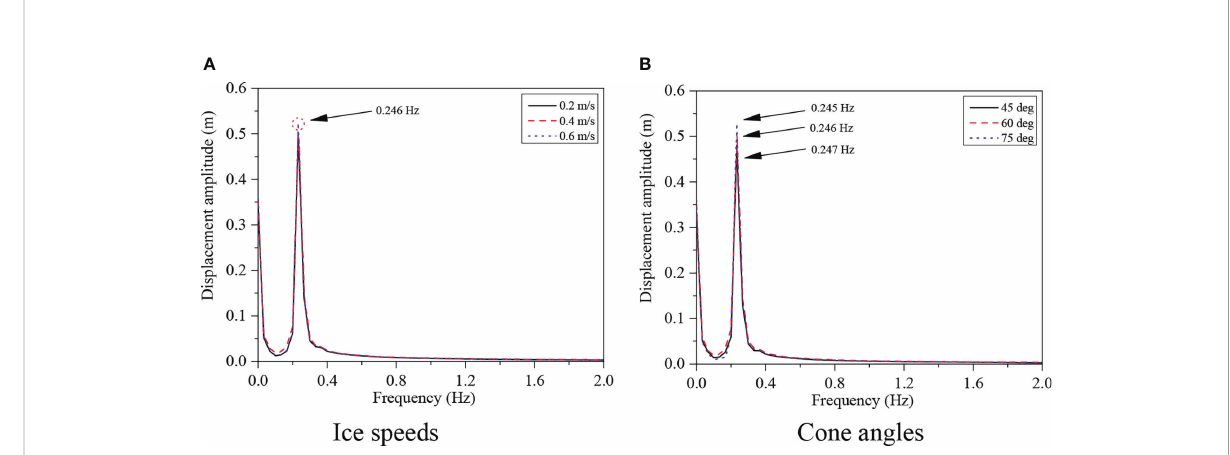
FIGURE 14 Fourier amplitudes of tower top displacements under selected wind-ice cases. (A) Ice speeds (B) Cone angles.